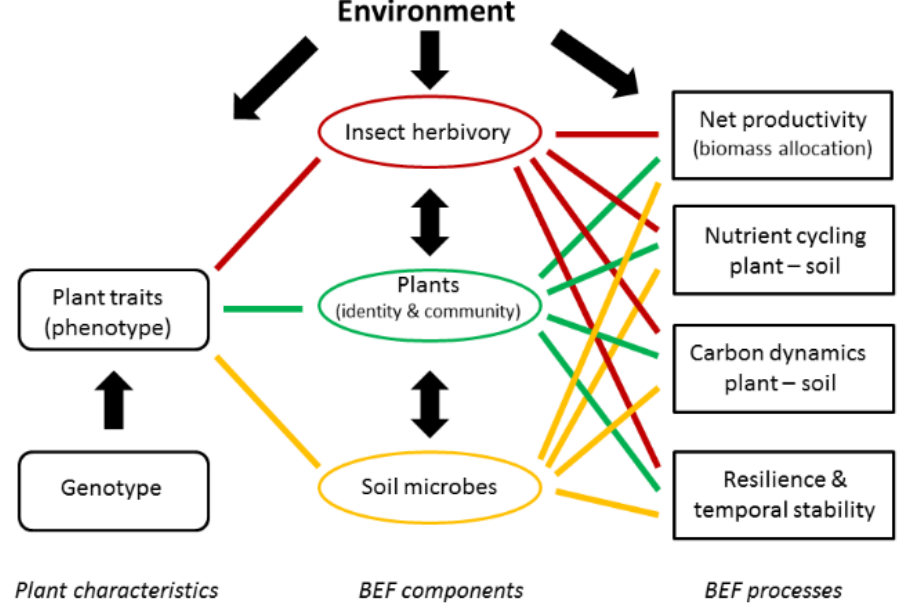
Figure 1. Conceptual overview of important relationships between plant (willow) traits and the biodiversity–ecosystem function (BEF) components and processes to be targeted when developing predictive BEF theory using willow short-rotation coppice (SRC) as a model. The BEF components relate to plant growth and productivity (green), insect herbivory as an important above ground trophic interaction (red), and soil microbes representing an important part of below ground trophic interactions (yellow). The BEF processes listed are considered important for the functioning of plant communities. Modified from [23] .